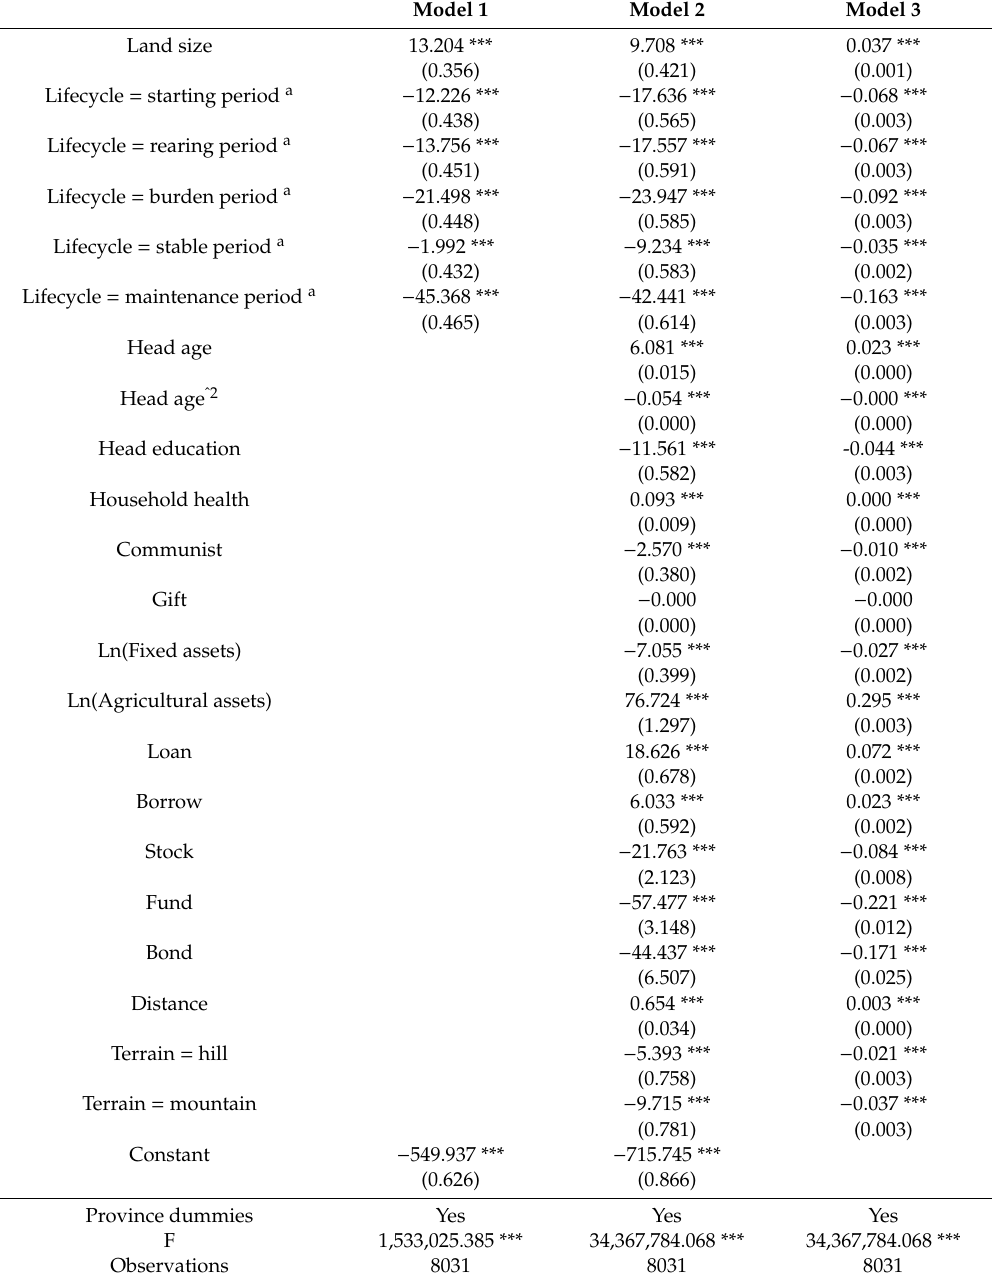
Table 5. Regression results of land management scale, family life cycle, and livelihood strategy